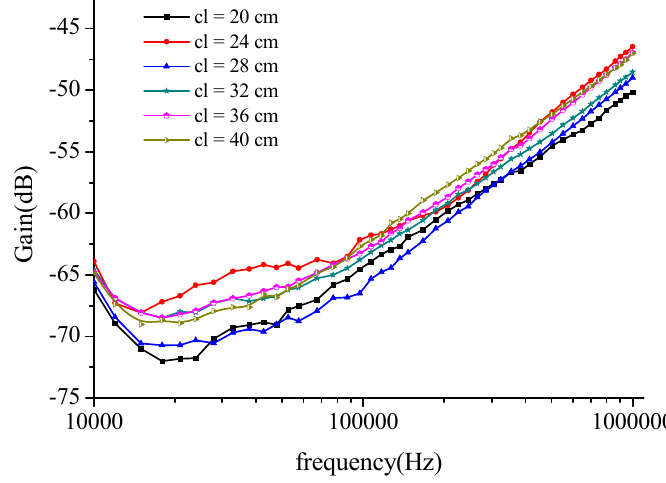
Figure 11. Mean values of the long distance intra-body communication channel characteristic, measured on 10 subjects at different distances.